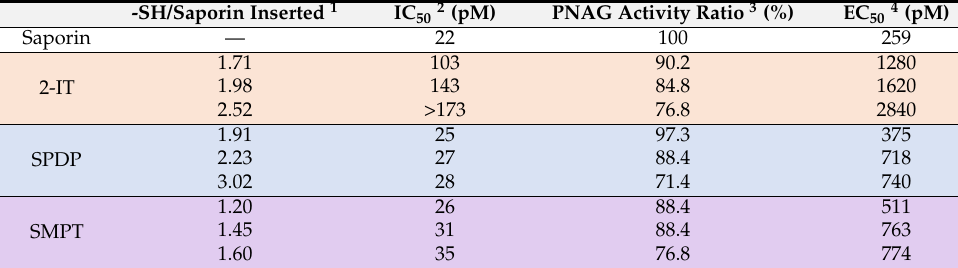
Table 4. Enzymatic and biological activities of saporin derivatized with 2-IT, SPDP or SMPT. -SH/Saporin Inserted 1 IC 50 2 (pM) PNAG Activity Ratio 3 (%) EC 50 4 (pM) Saporin — 22